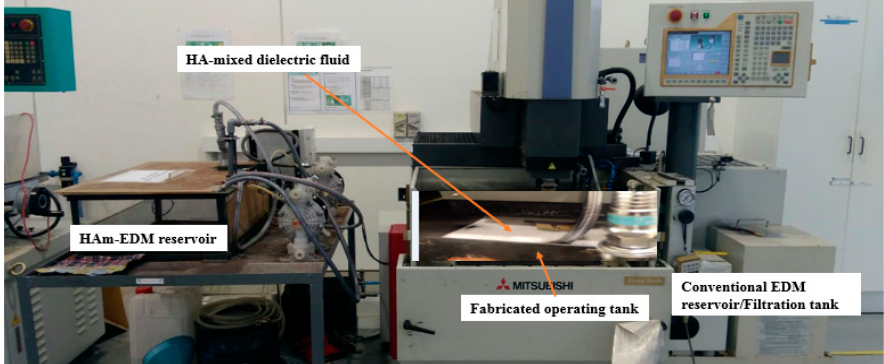
Figure 2. Hydroxyapatite mixed electro-discharge machining (EDM) (HAm-EDM) experimental set-up indicating the fabricated HAm-EDM components and the conventional EDM machine.